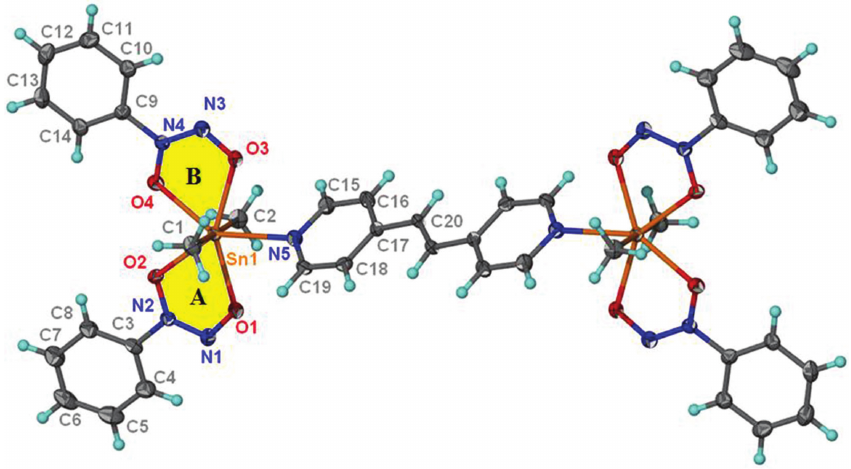
Figure 1: A perspective view of the molecular structure of tin complex drawn with 50% probability